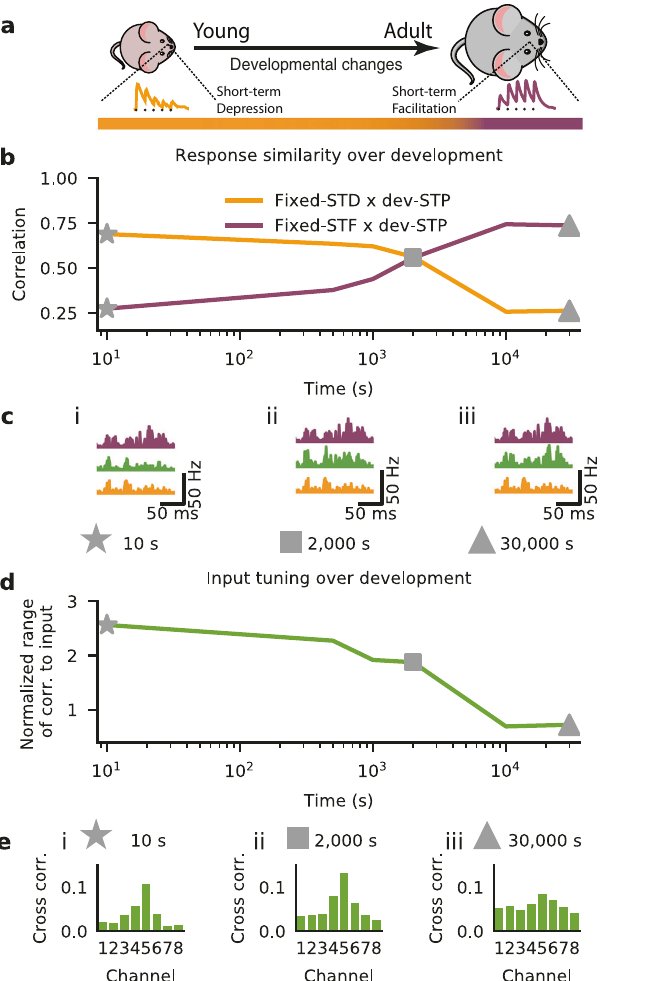
Fig. 4 Input – output response correlations over development. a Schematic of the modeled development from young with depressing synapses (left) to adult facilitating synapses (right). Bottom color bar indicates the gradual shift in STP (as in Fig. 2). b Correlation of the dev-STP model response pro fi les to that of the fi xed-STD (orange) and fi xed-STF (purple) scenarios during development. c Example output responses (cf. Fig. S6) for the fi xed- STD (orange), fi xed-STF (purple), and dev-STP (green) models at three points in simulated development (i: 10 s, stars; ii: 2000 s, squares; iii: 30000 s, triangles). d Normalized range of correlation to input (Methods). e Example of output correlations at speci fi c times during the course simulated development (same timings as in c ). Results shown here were averaged over 50 trials.